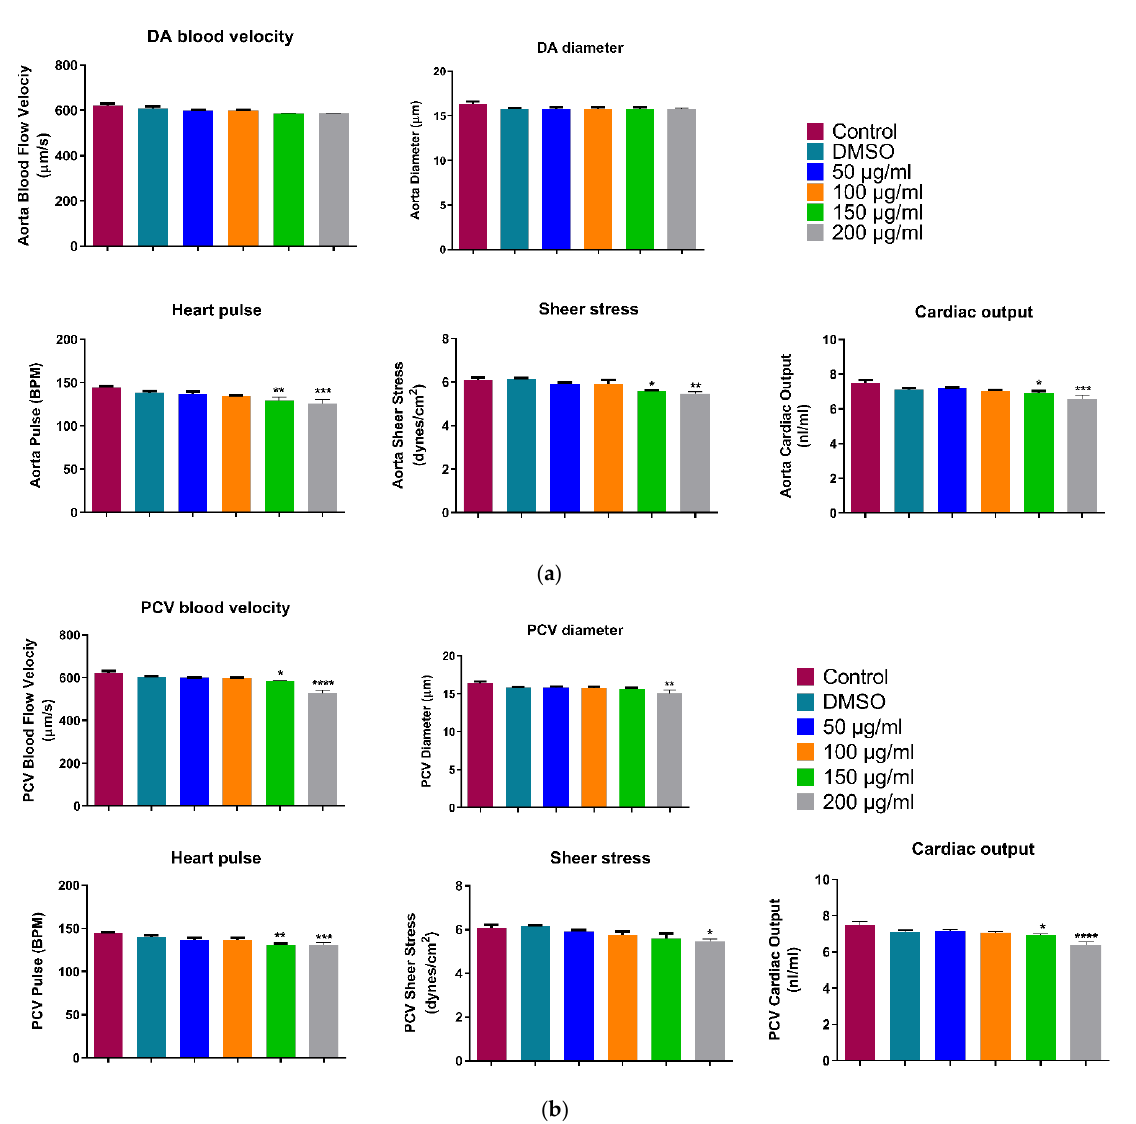
Figure 6. Assessment of the cardiac function of the experimental groups at 72 h post-fertilization ( a ) DA and ( b ) PCV blood flow analysis. All data are presented as mean ± SEM (6 embryos were used in each group; the experiment was performed in triplicate). The analysis was done by one-way ANOVA with Sidak post hoc test. * p < 0.05, ** p < 0.01, *** p < 0.001 and **** p < 0.0001.